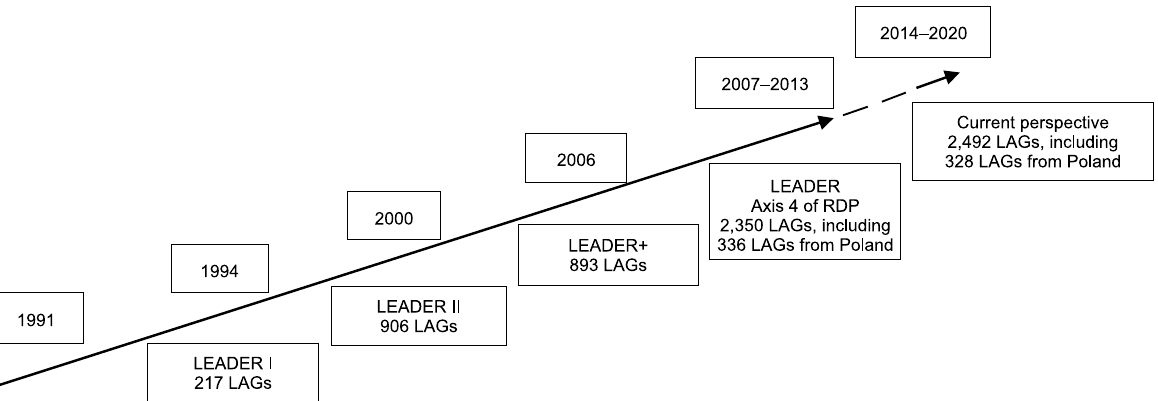
Fig. 2. Five stages of the LEADER programme and the number of LAGs implementing the programme in individual